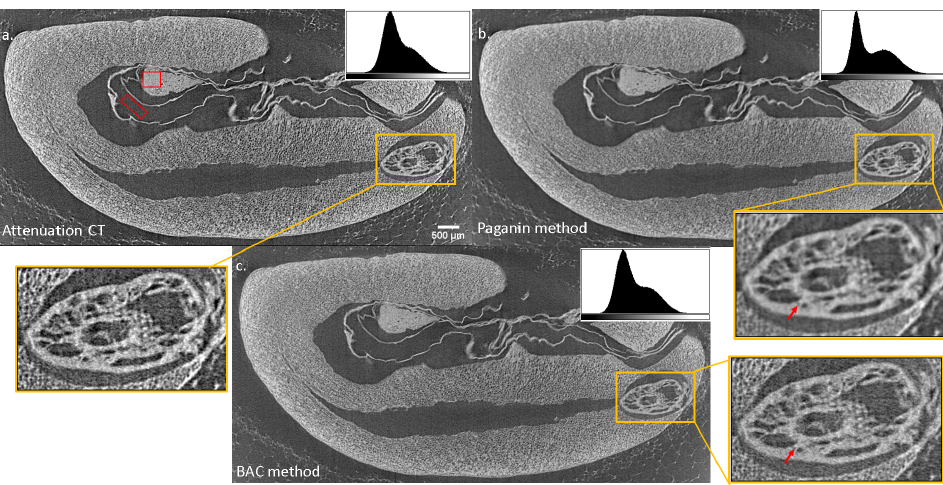
Figure 3. ( a ) Attenuation-based micro-CT image of a coffee bean. Propagation-based micro-CT images of the coffee bean reconstructed by ( b ) Paganin’s phase retrieval method, Equation (6), and ( c ) by the BAC method Equations (3) and (4). Note the foamy looking material around the bean is florist’s foam in which the bean was embedded for the scan. The insets in the upper right corner of each image show the gray value histograms. It shows that the separation, i.e., CNR increases for the BAC and Paganin retrieval compared to the attenuation case. The regions of interest outlined in orange show with higher magnification how the different retrievals might blur the visibility of small-scale feature (see, e.g., red arrows). For the BAC method the optimized parameters from Figure 2b, whereas for the Paganin method ν = 10.0 were used. The areas circumvented in red indicate the ROIs used for determining the CNR values between sample material and air (see the values in Table